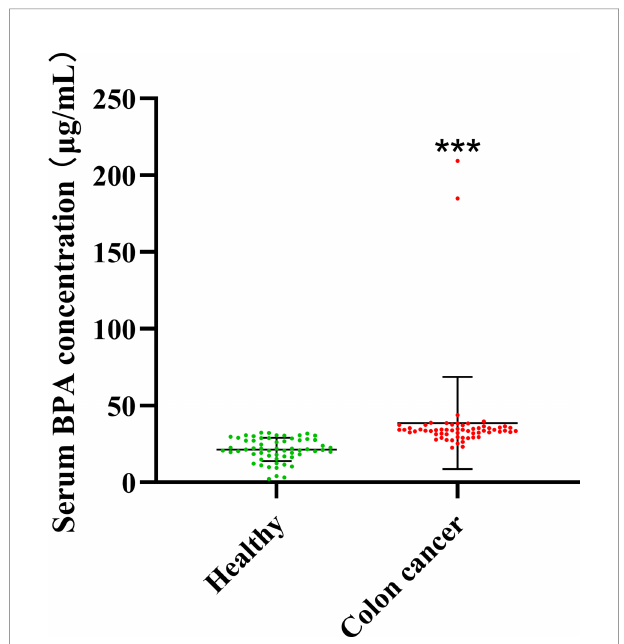
FIGURE 1 | Concentration of BPA in serum from healthy donors and individuals with colon cancer. Values are expressed as means ± SD (n = 60), compared with the healthy group, *** p <